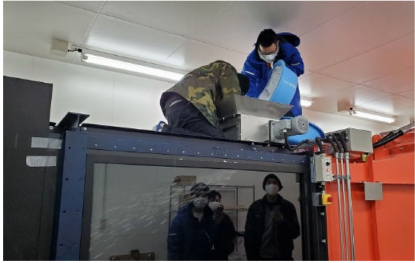
Figure 19. Process of snow injection during the